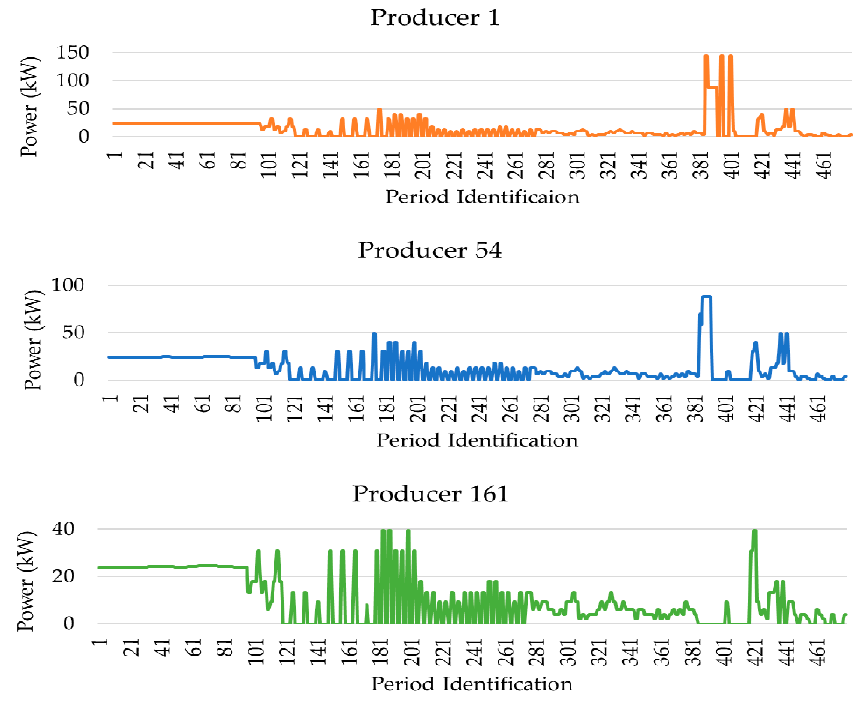
Figure 7. Optimization results for three wind producers.